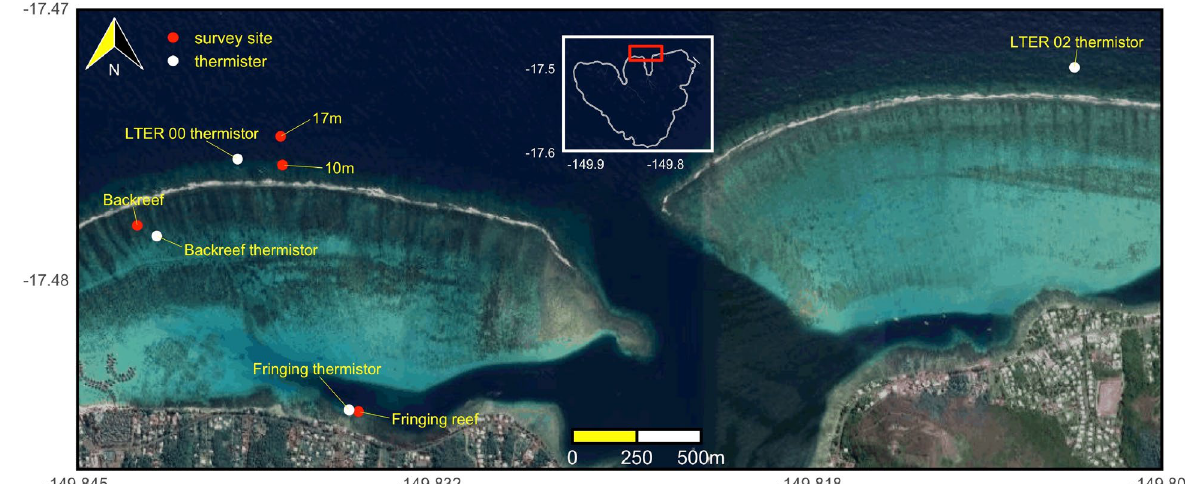
Figure 1. Map showing the four habitats (fringing reef, backreef, 10 m, and 17 m on the fore reef) and thermistor locations in Moorea, French Polynesia. Photo credit: Google